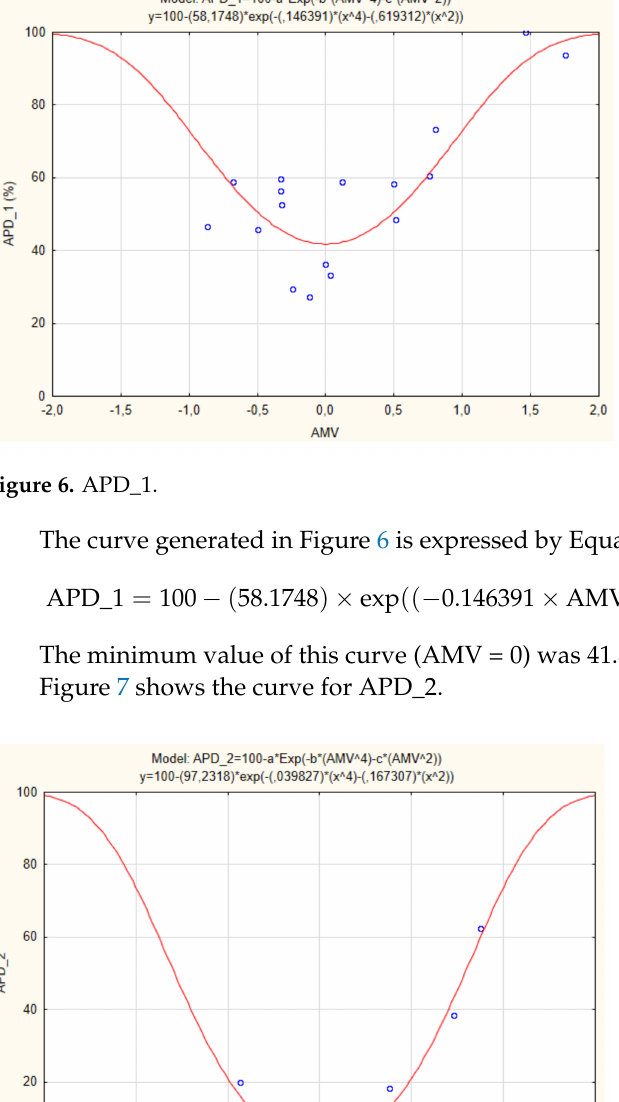
Figure 7. APD_2. The curve generated in Figure 7 is expressed by Equation (4):